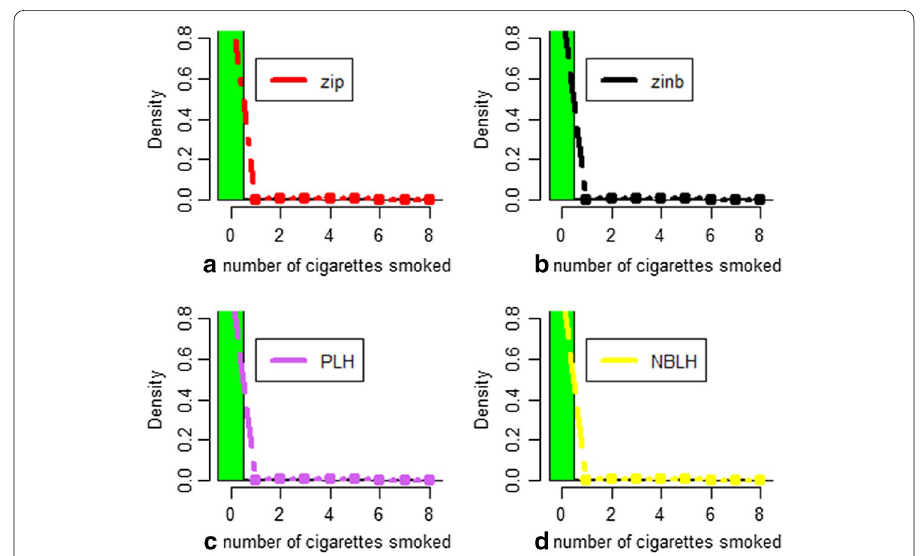
Fig. 3 Comparison of the densities of each model fits a – d observed and predicted frequencies of smoke occurrence for ZIP, ZINB, PLH, NBLH models